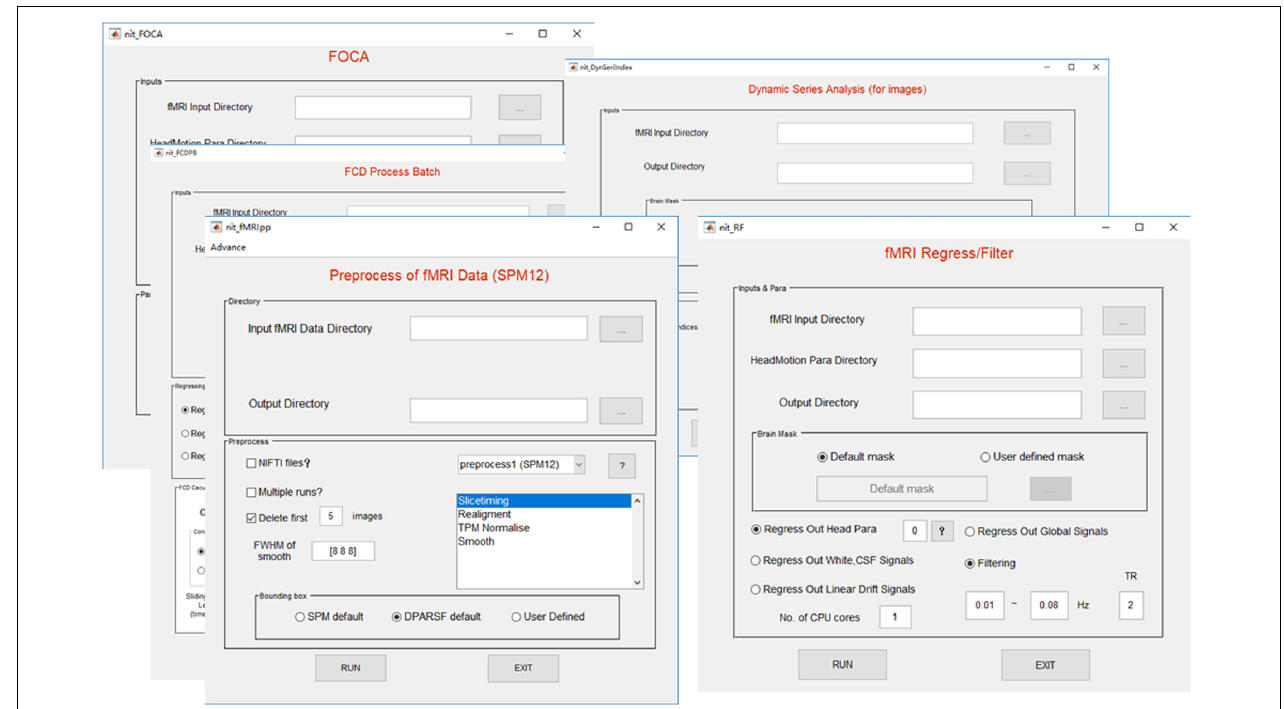
FIGURE 3 | Interfaces of the fMRI module